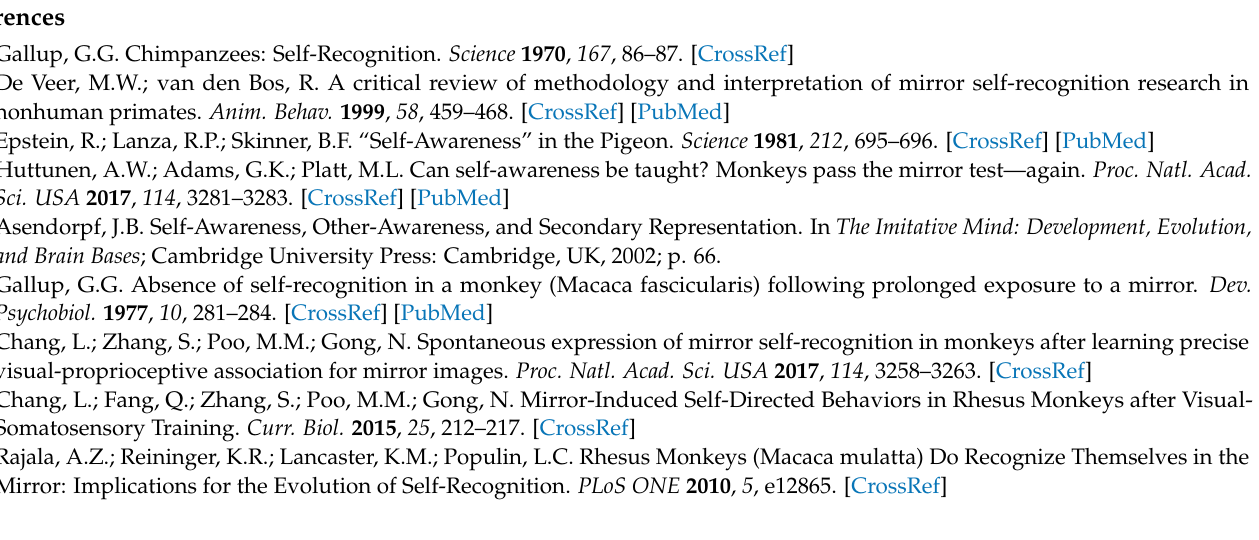
Figure 1. A.C. is a research director with the F.R.S-FNRS (Belgium). Conflicts of Interest: The authors declare no conflict of interest. The funders had no role in the design of the study; in the collection, analyses, or interpretation of data; in the writing of the manuscript; or in the decision to publish the